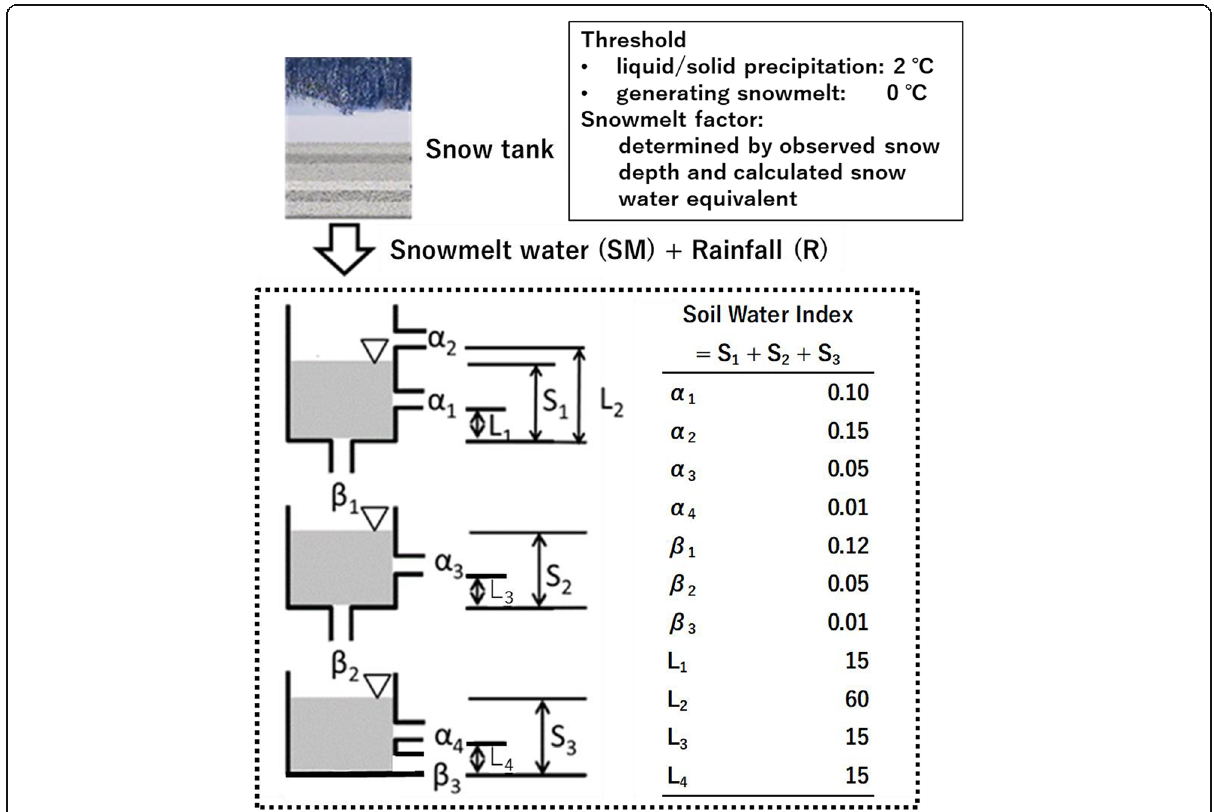
Fig. 1 Schematic diagram of the three-layer tank model plus snow tank, modified after Shimizu and Uemura (2018). The figures and table within the dotted box represent original SWI (Okada et al. 2001). α 1-4 and β 1-3 are dimensionless while L 1-4 and S 1-3 have unit of mm. The parameters related to snow are shown in the solid